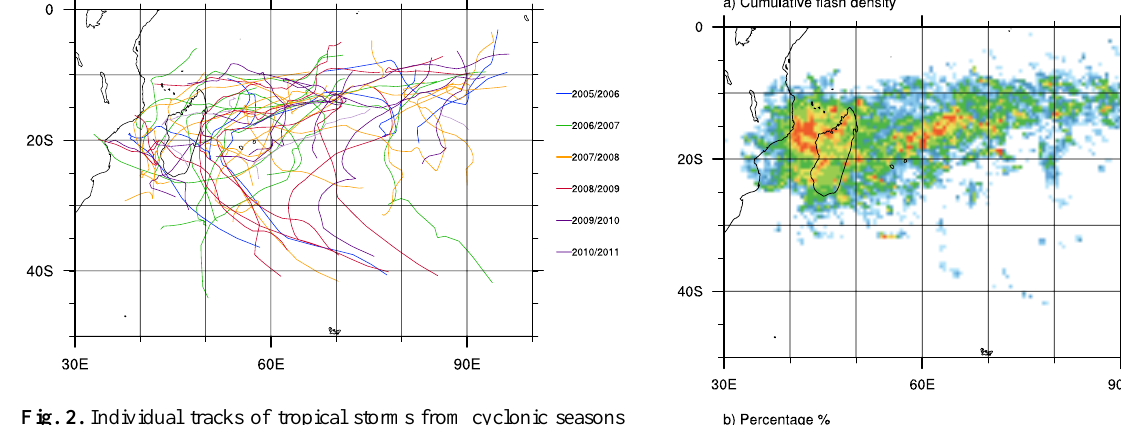
Fig. 2. Individual tracks of tropical storms from cyclonic seasons 2005/2006 to 2010/2011 in the SWIO. Source: RSMC La R´eunion. best-track database. The tracks of the 51 tropical storms and sons 2005/2006 and 2010/2011 are represented in Fig. 2.